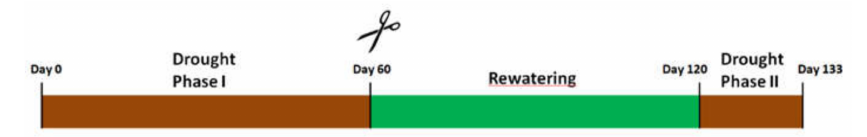
Figure 1. Schematic illustration of the experimental design. Two months after sowing, the first round of drought stress was carried out for 60 days. Then, the second period of water deficit was